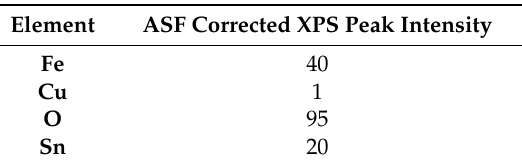
Figure 4. ( a – e ) XPS spectra and ( f ) Raman spectrum for the CuSn sample. Table 2. XPS intensity ratio.